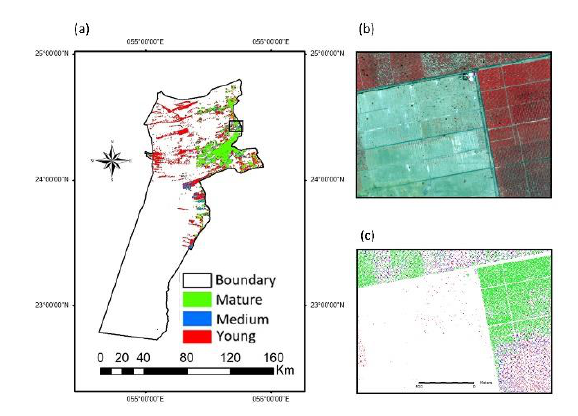
Figure 5. Vegetation bitmap and derived mature date palm